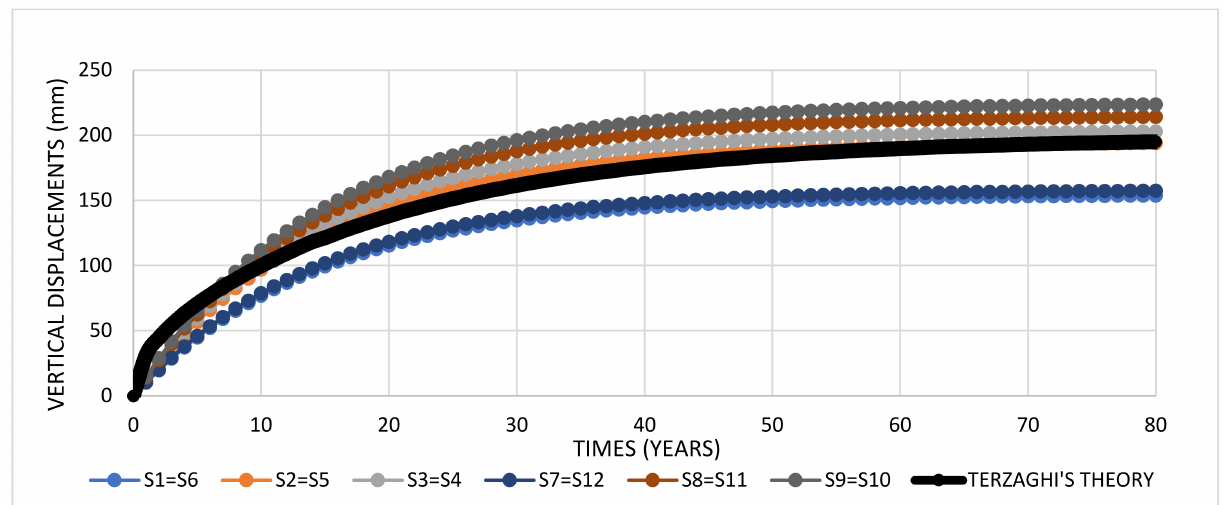
Figure 7. Vertical displacements on footings, with soil–foundation interaction, obtained for Terzaghi’s theory fitting at t = 0.